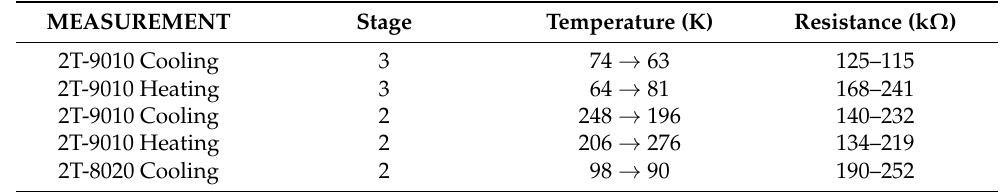
Table 2. Temperature and resistance values at the moment of metal–insulator transition of the samples and of the insulator–semiconductor back transition.